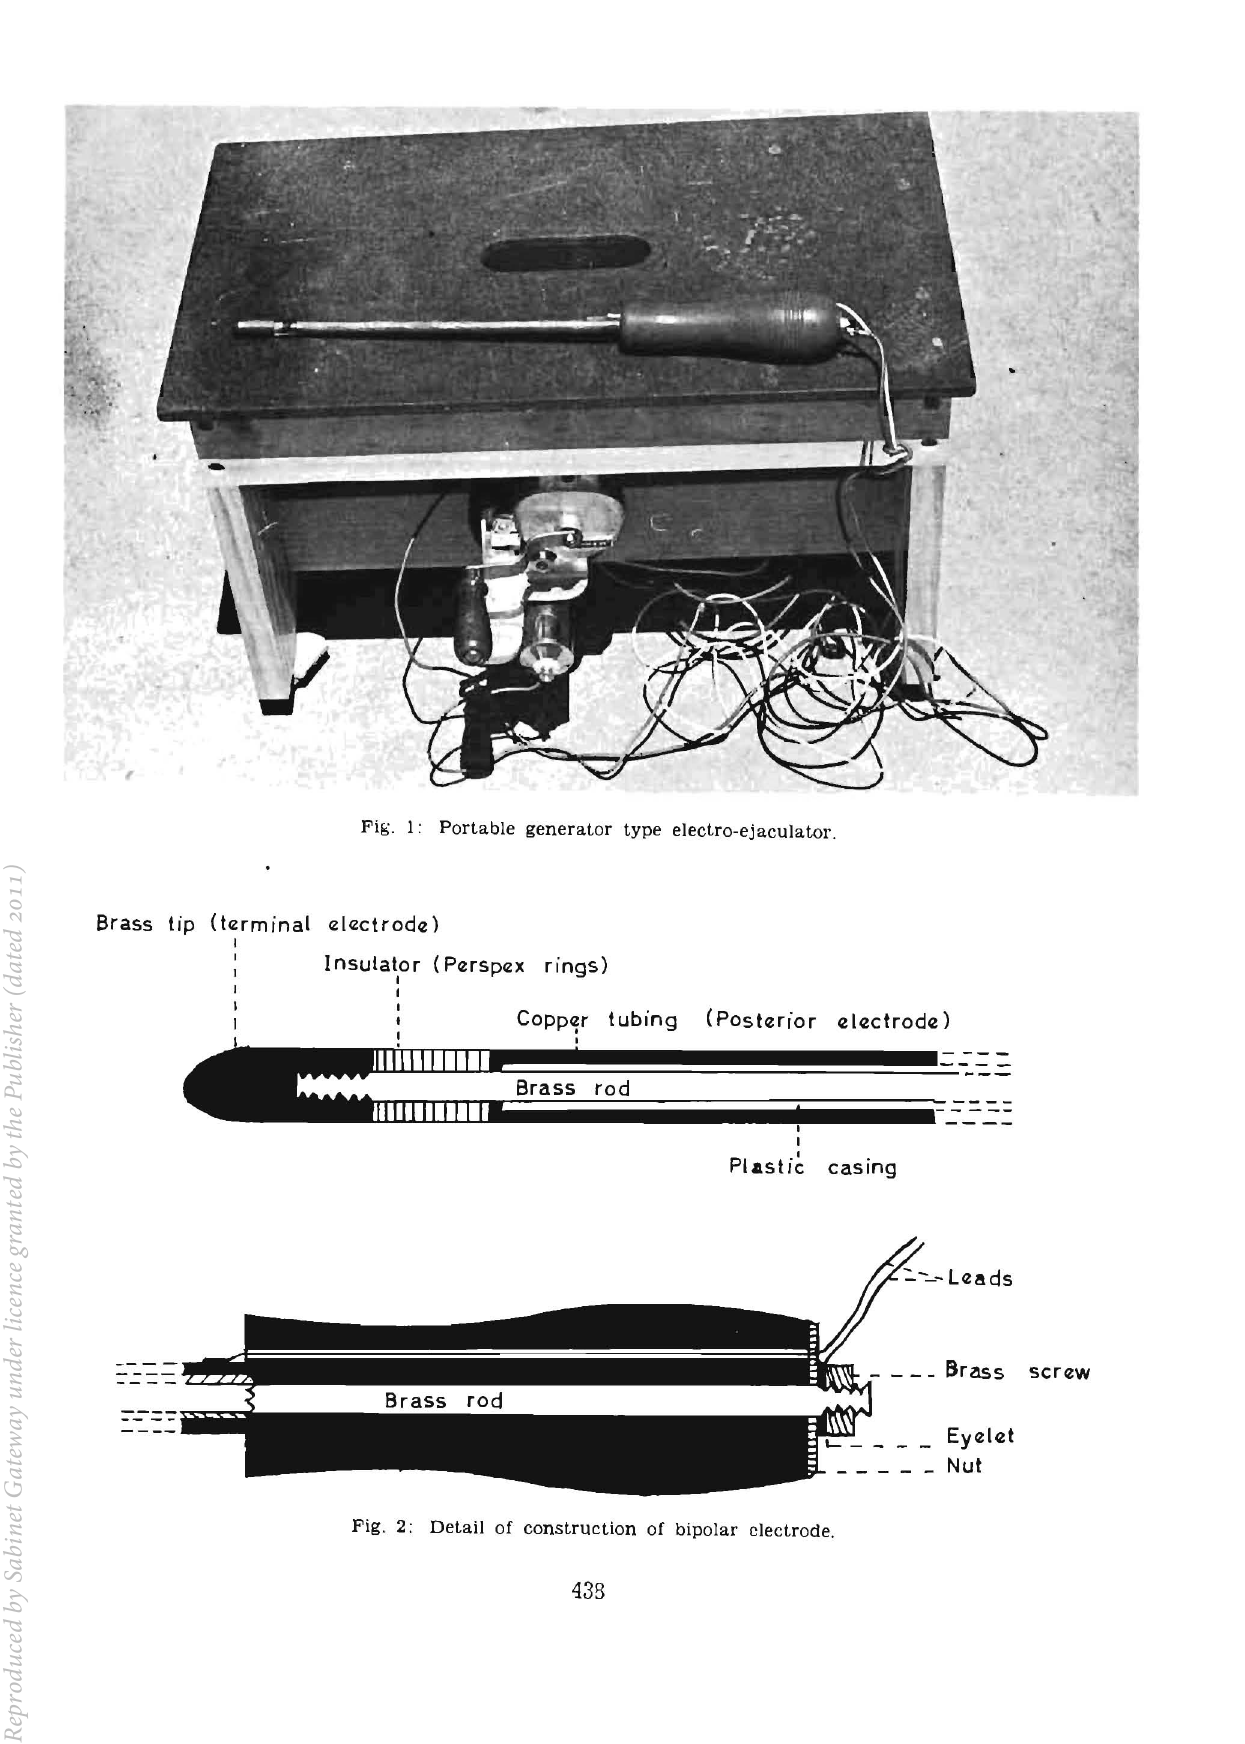
Fig. 2: Detail of construction of bipolar electrode.